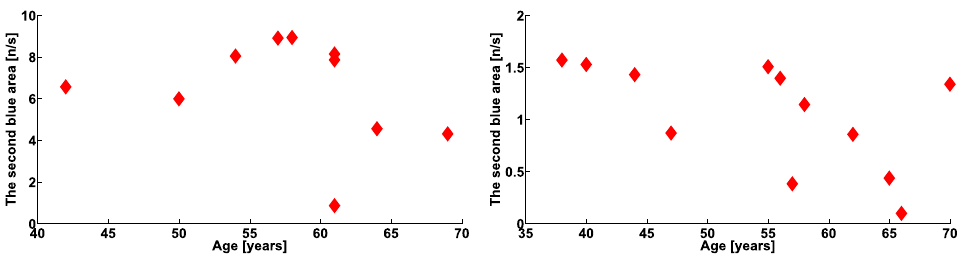
Figure 16. Scatter plots of number of cross-wave trains per second in arms with hyperkinetic movements in PD patients vs. patient age. The abscissa axis is the age in years. The ordinate axis is the number of cross-wave trains per second. ( Left ), the left arms of the subjects are considered: frequency range is 10–37 Hz. ( Right ), the right arms of the subjects are considered: frequency range is 12–37